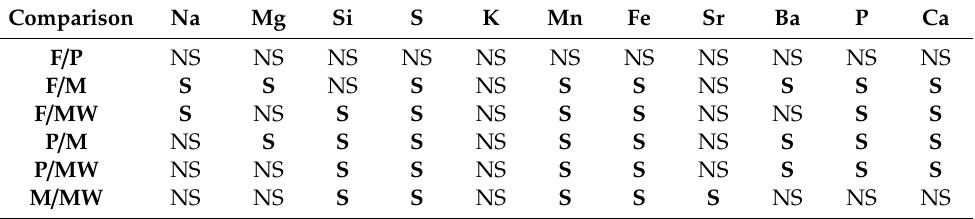
Table 2. Mann–Whitney test at α = 5% based on the chemical analyses of modern and fossil fish bones; F: fresh bones, P: bones extracted from pellets, M: Malema fossil samples, MW: Mwenirondo fossil samples, S : significant di ff erences, NS: non-significant di ff erences.